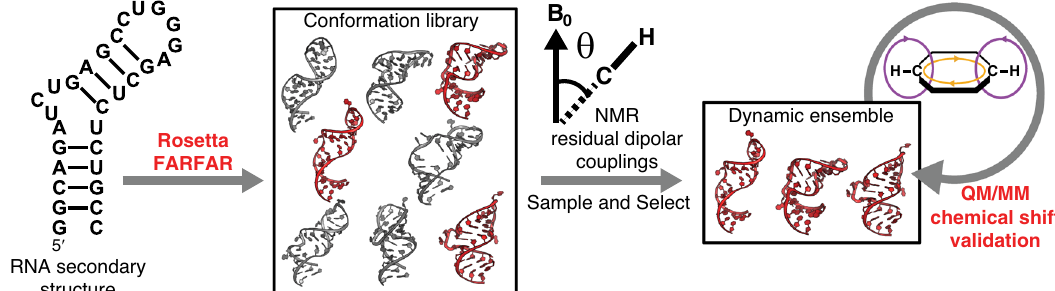
Fig. 1 The FARFAR-NMR pipeline. An RNA conformation library is generated by Rosetta FARFAR structure prediction using an RNA secondary structure. The FARFAR-NMR ensemble can be re fi ned from the conformation library using NMR RDCs and cross-validated by computing NMR chemical shifts using QM/MM